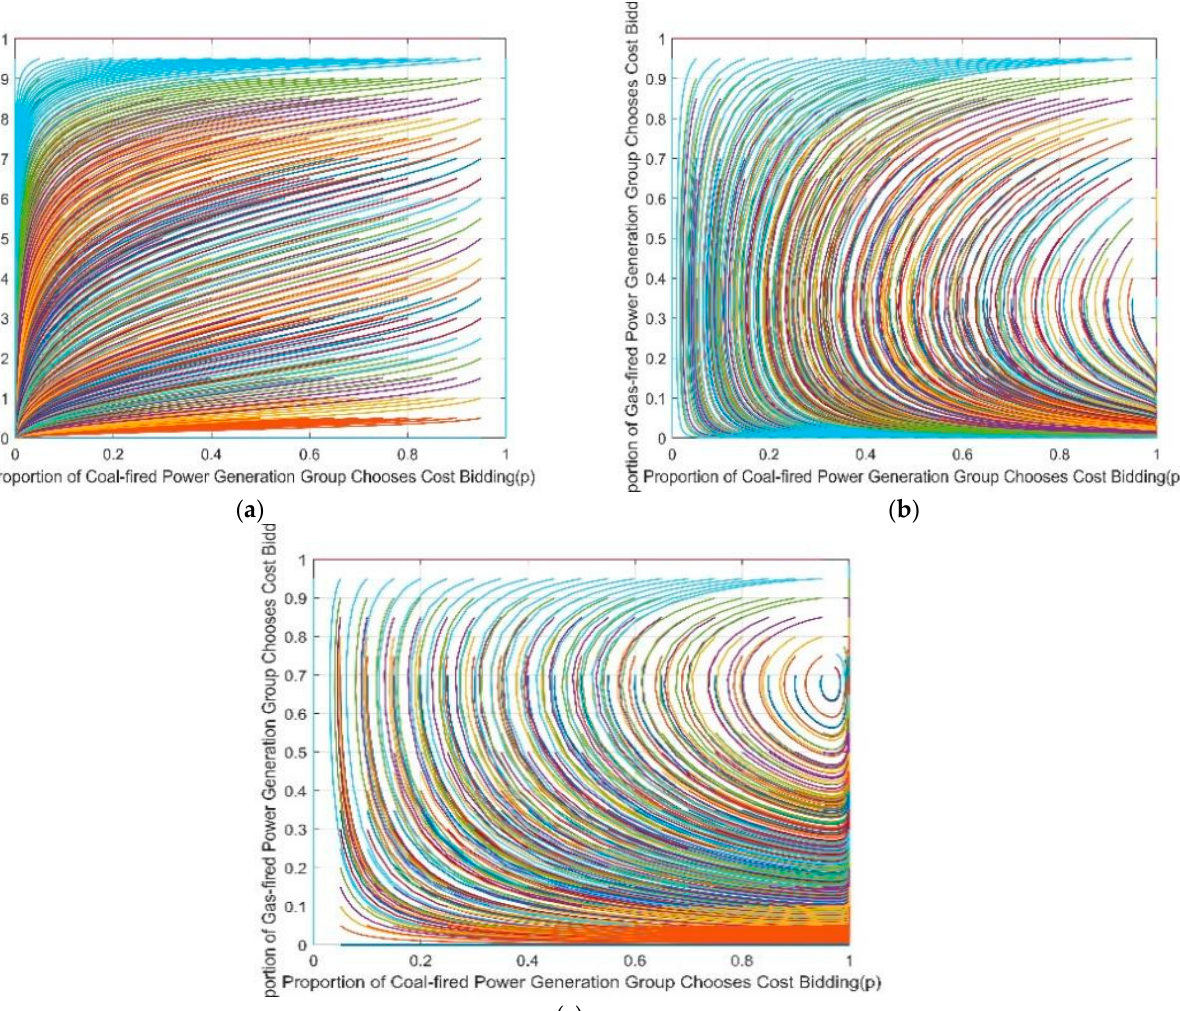
Figure 7. Evolution trend of bidding entities in phase 3 under scenario 1. ( a ) Simulation results of the evolution of coal-fired and gas-fired feed-in tariffs under “Condition 1” in Scenario 1.2-a, ( b ) Simulation results for increasing the feed-in tariff for gas-fired generators to satisfy "Condition 2" in Scenario 1.2-a, ( c ) Simulation results of increasing the feed-in tariffs of gas-fired generators again to satisfy "condition three" in scenario